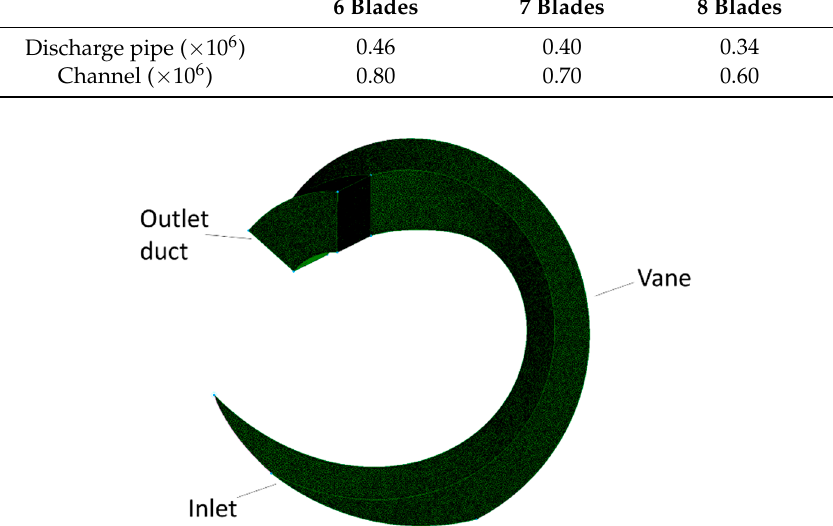
Figure 4. Grids of the single vane geometries with different number of blades.